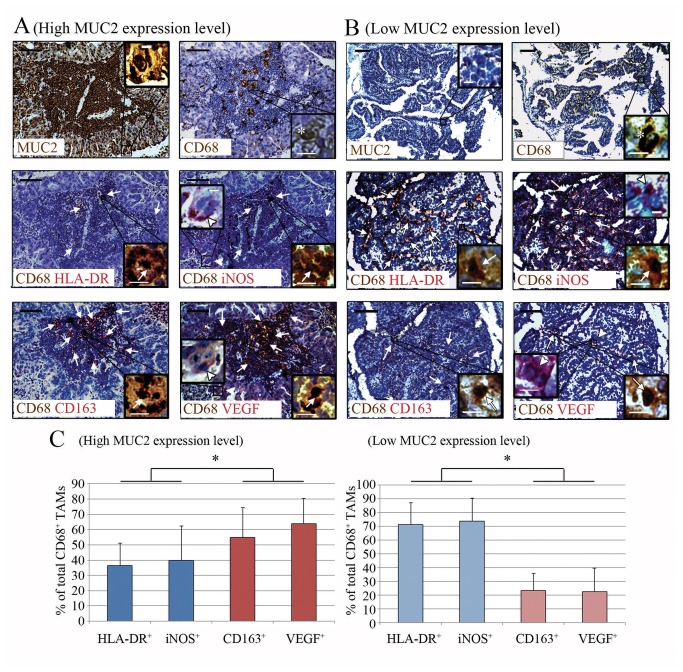
Total CD68+ TAMs and their M1 and M2 subsets in the ovarian cancer tissue.(A) Representative MUC2 and CD68 single-immunostained and CD68/HLA-DR, CD68/iNOS, CD68/CD163, CD68/VEGF double-immunostained sections from the high MUC2 expression group. (B) Representative MUC2 and CD68 single-immunostained and CD68/HLA-DR, CD68/iNOS, CD68/CD163, CD68/VEGF double-immunostained sections from the low MUC2 expression group. For VEGF- and iNOS-immunostaining, cancer cells (in red) that independently expressed these two proteins can be found in the cancer tissue sections from both groups (arrowhead). Asterisk, TAMs (in brown) that expressed the CD68 protein. Arrow, CD68+ TAMs (in purple) that co-expressed the indicated proteins (HLA-DR, iNOS, CD163 or VEGF). Scale bar (black), 100 μm. Inset scale bar (white), 10 μm. (C) Comparison of the percentages of different M1 and M2 cell subsets (i.e., M1/M2 distribution patterns) among all the TAMs. It could be noted that the percentages of M1 macrophages were significantly higher than those of M2 macrophages in the high MUC2 expression group; but on the contrary, the percentages of M1 macrophages were significantly lower than those of M2 macrophages in the low MUC2 expression group. *, p<0.05, ANOVA.